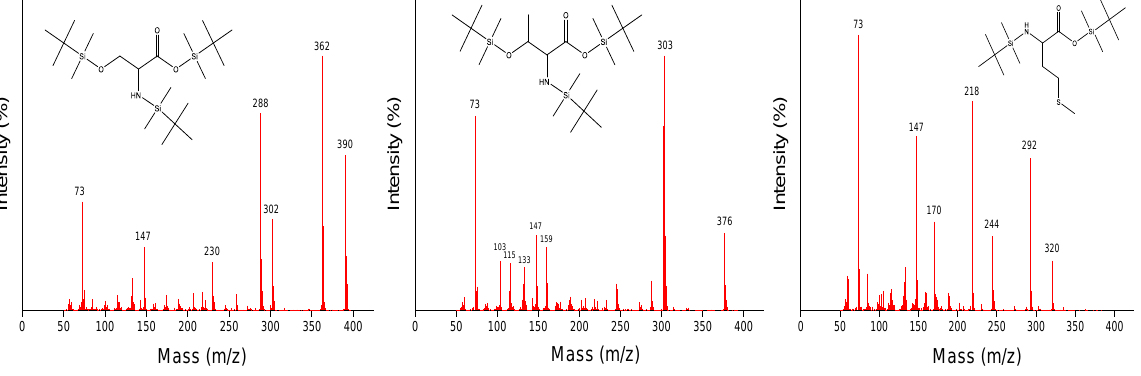
Figure 8. Mass spectra of coeluting derivatized serine, threonine and methionine.